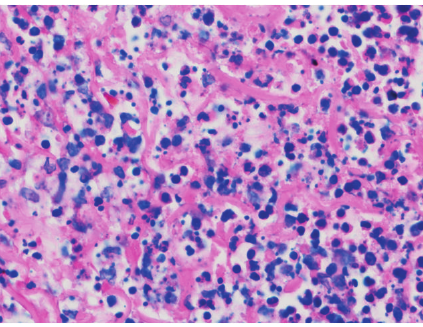
Figure 5: High-power Giemsa: parasitized histiocytes with diffuse staining of Leishmania